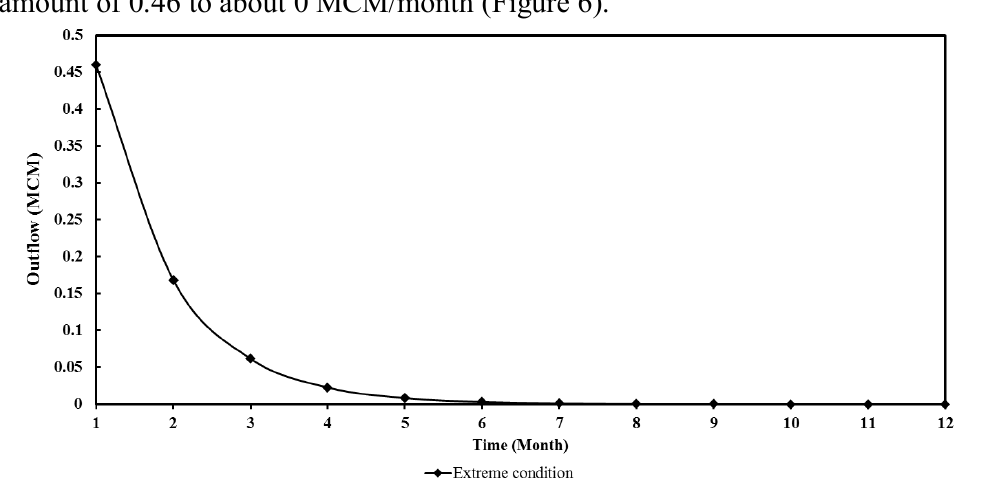
Figure 6. The results of the Outflow under the extreme